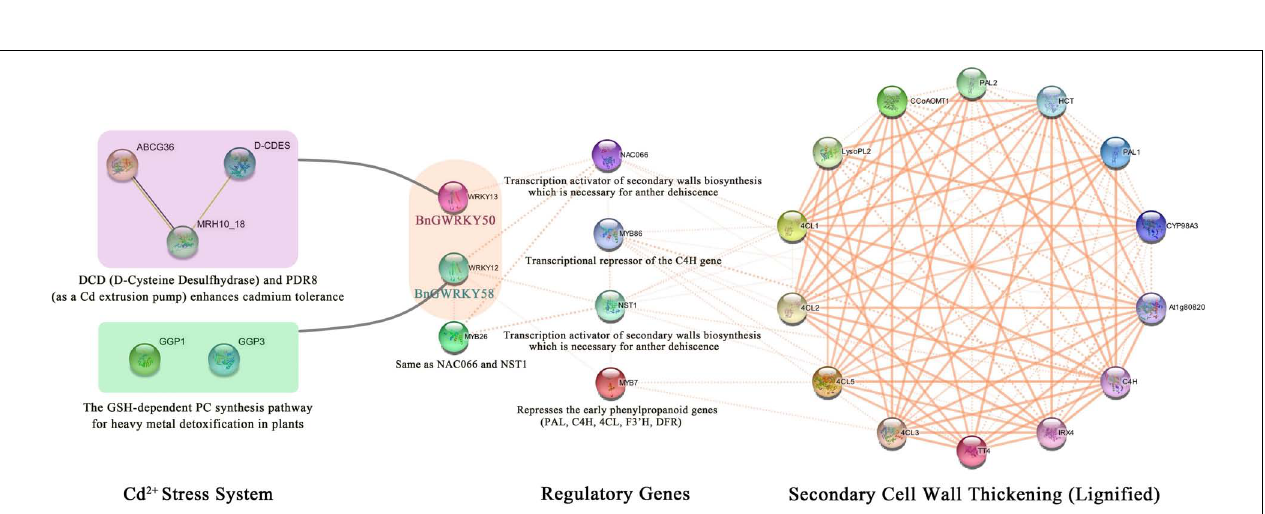
FIGURE 12 | A BnGWRKY protein interaction network based on Arabidopsis